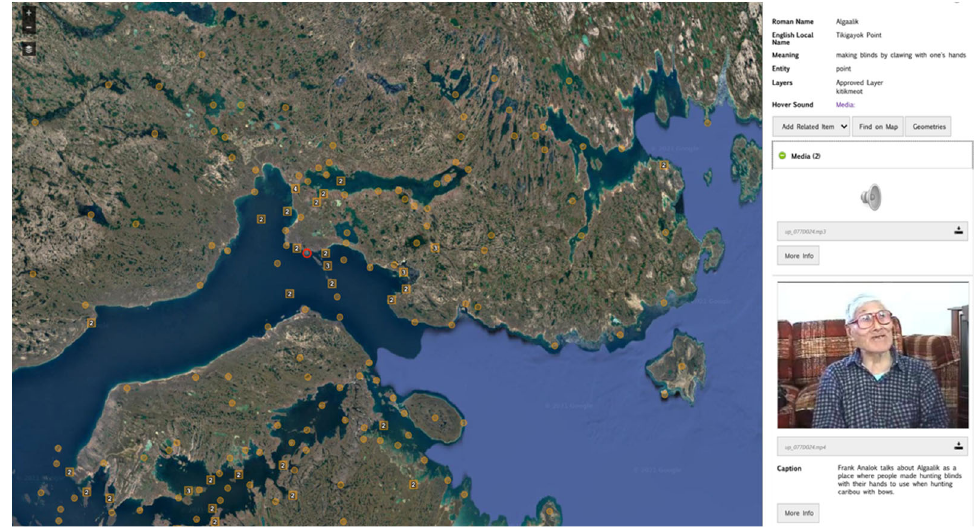
Figure 3. A video of elder Frank Analok is linked to the Tikiraaryuk site and describes its history of use for seal hunting and iglu building. Each yellow dot on the map represents a unique place name and associated data.